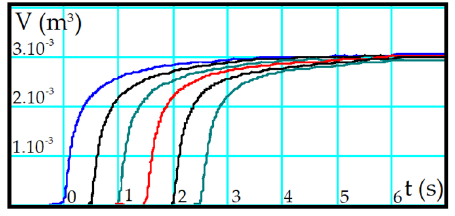
Figure 2. Volume versus Time chart generated by Koko spirometer.